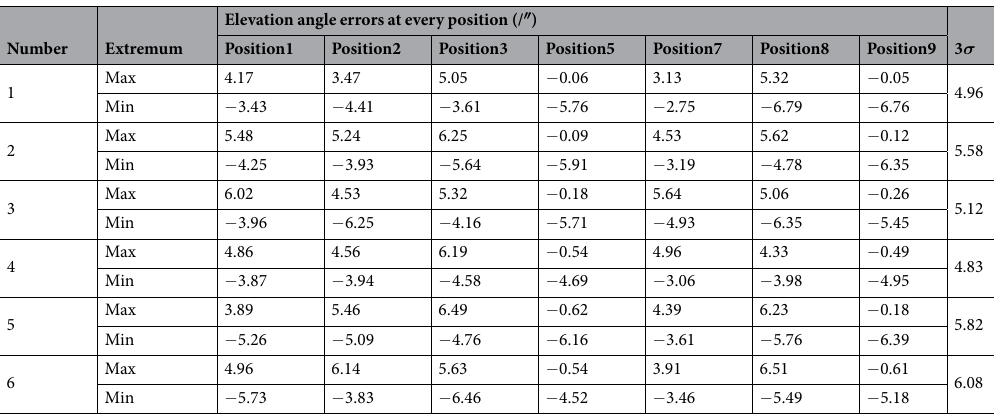
Table 6. The elevation errors of dynamic precision